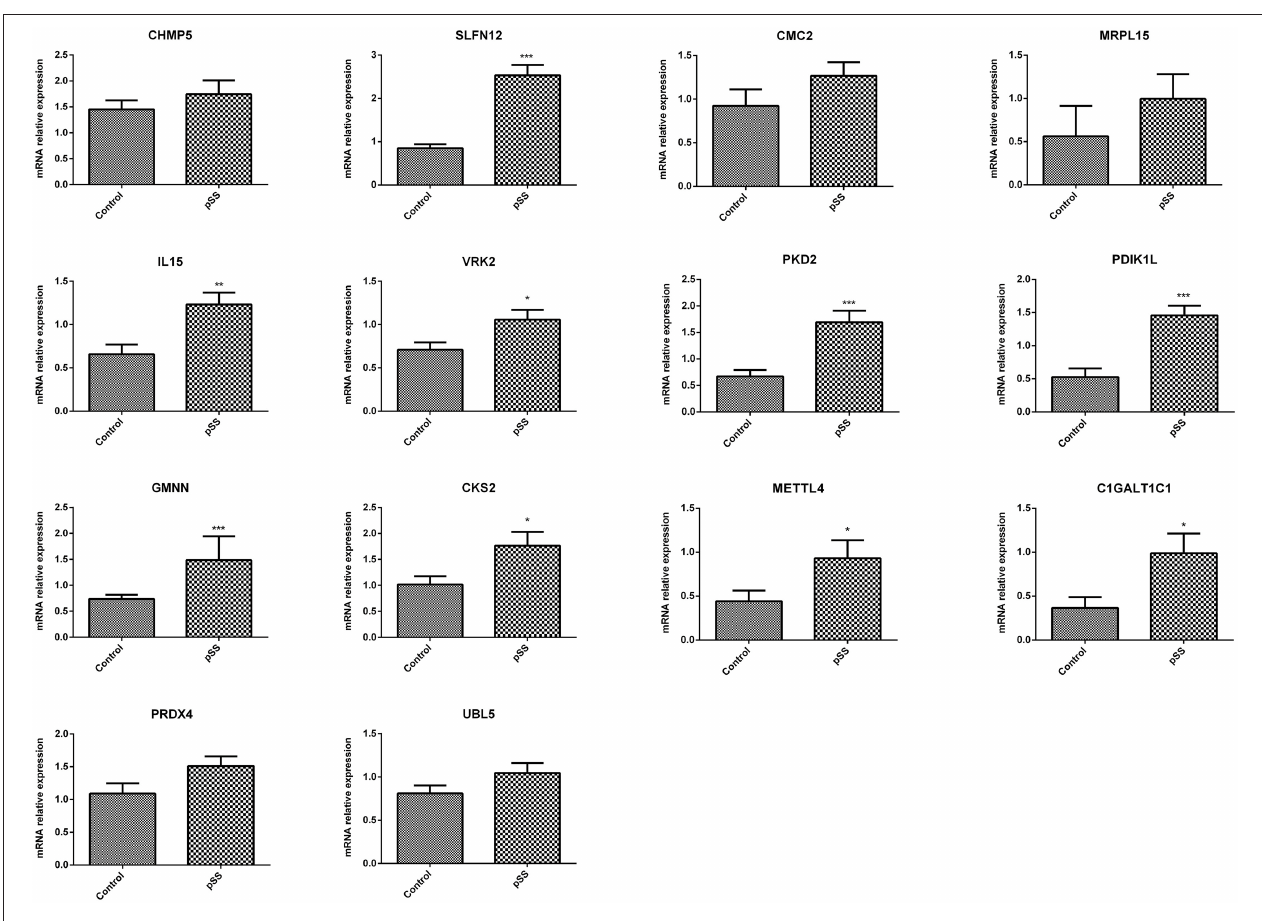
FIGURE 8 | Quantitative real-time PCR (RT-qPCR) analysis to verify the feature genes. * P < 0.05; ** P < 0.01; *** P <